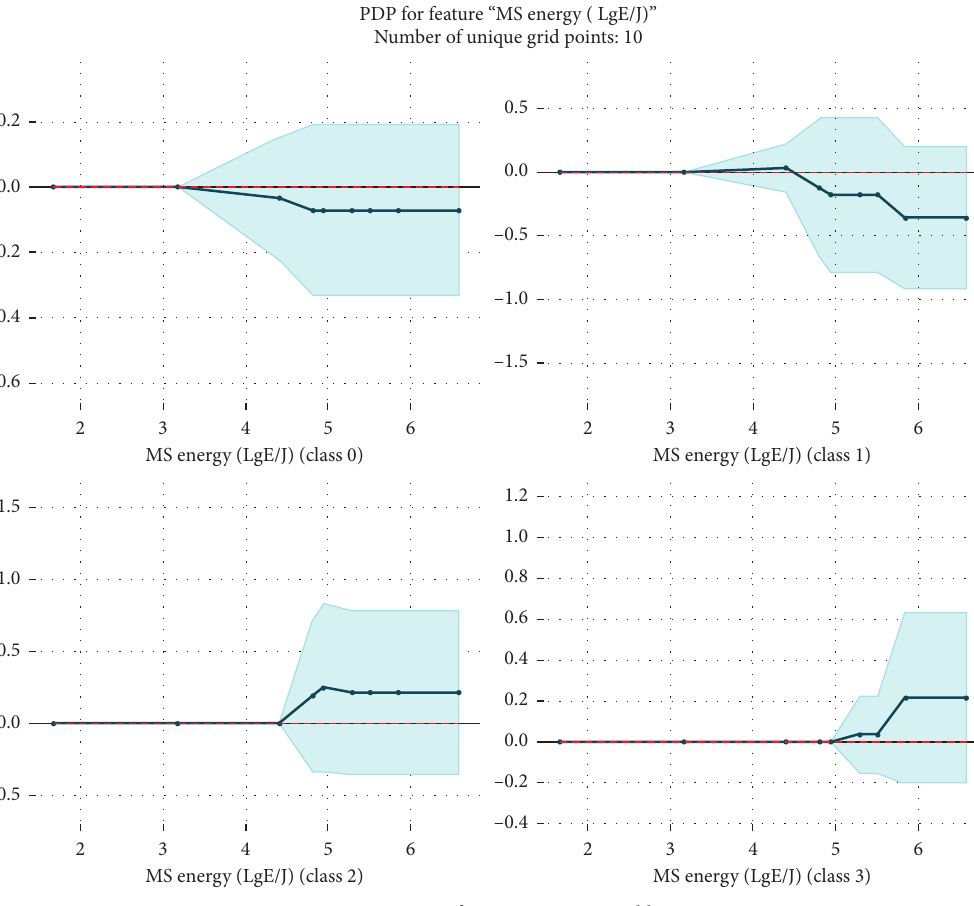
Figure 7: Impact of MS energy on